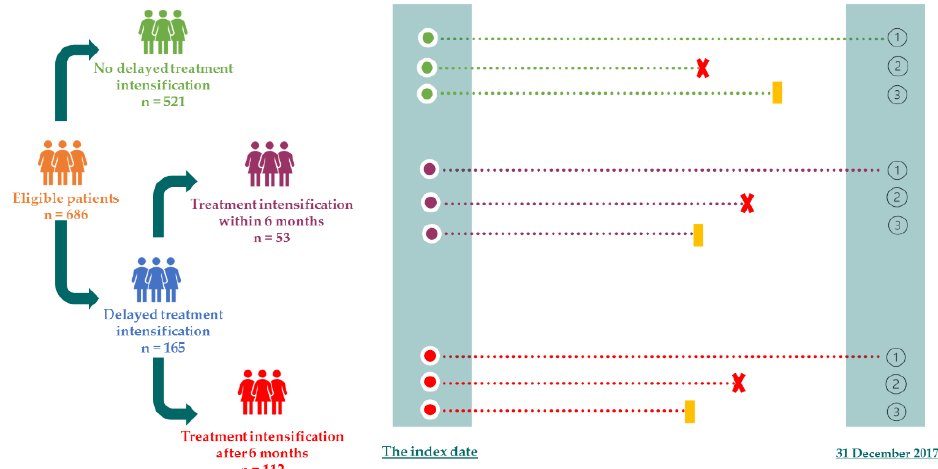
Figure 1. Study protocol. Patients were classified into three groups based on the time of treatment Figure 1. Study protocol . Patients were classified into three groups based on the time of treatment Figure 1. Study protocol . Patients were classified into three groups based on the time of treatment intensification, then the patients were followed up for diabetes-related complications from the index intensification, then the patients were followed up for diabetes-related complications from the index intensification, then the patients were followed up for diabetes-related complications from the index date to 31 December 2017. 1 (cid:13) The patient had no diabetes-related complications until the end date of date to 31 December 2017. ① The patient had no diabetes-related complications until the end date Figure 1. Study protocol . Patients were classified into three groups based on the time of treatment date to 31 December 2017. ① The patient had no diabetes-related complications until the end date of the follow-up; ② The patient was lost to follow-up; ③ The patient had diabetes-related compli- the follow-up; 2 (cid:13) The patient was lost to follow-up; 3 (cid:13) The patient had diabetes-related complications. intensification, then the patients were followed up for diabetes-related complications from the index of the follow-up; ② The patient was lost to follow-up; ③ The patient had diabetes-related compli- date to 31 December 2017. ① The patient had no diabetes-related complications until the end date cations. cations. of the follow-up; ② The patient was lost to follow-up; ③ The patient had diabetes-related compli- cations.